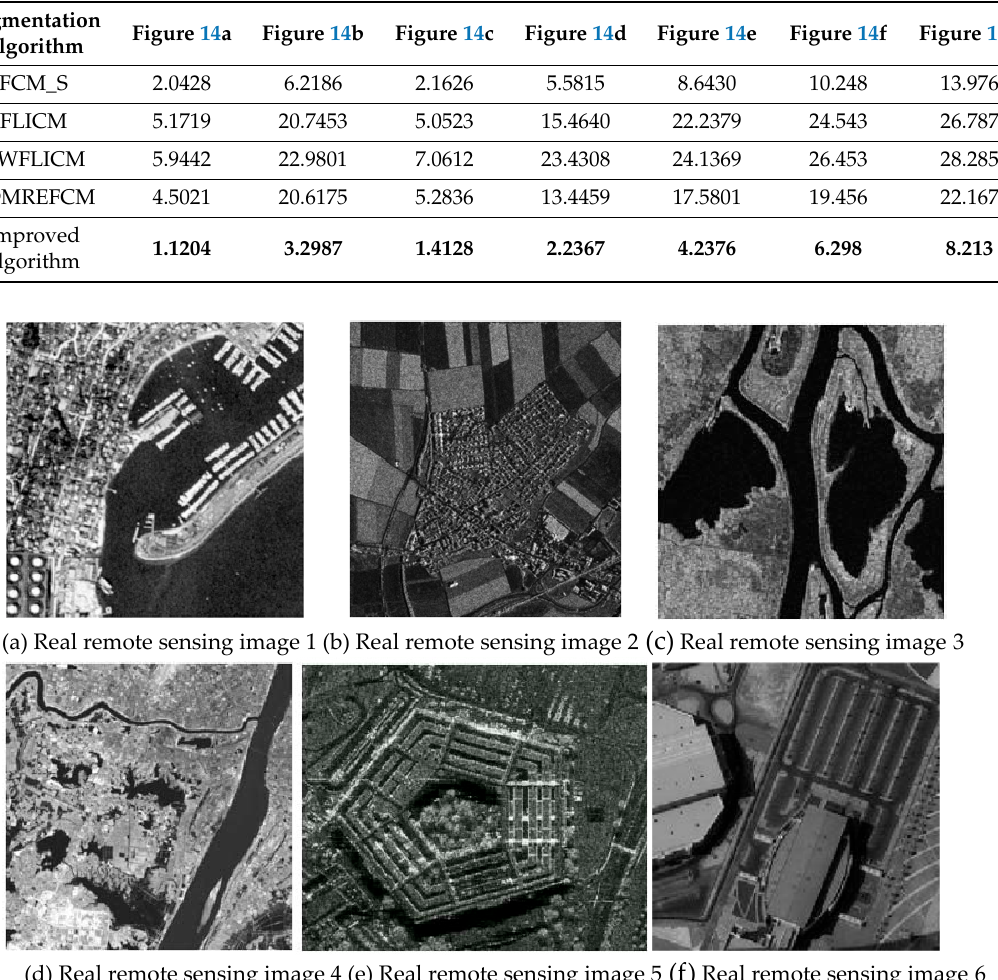
Table 10. Segmentation time of real remote sensing images with di ff erent sizes by each algorithm.